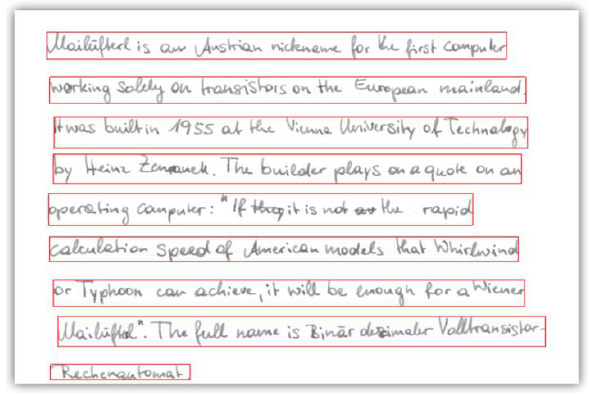
Figure 5. Line segmentation of a handwritten image of the CVL dataset